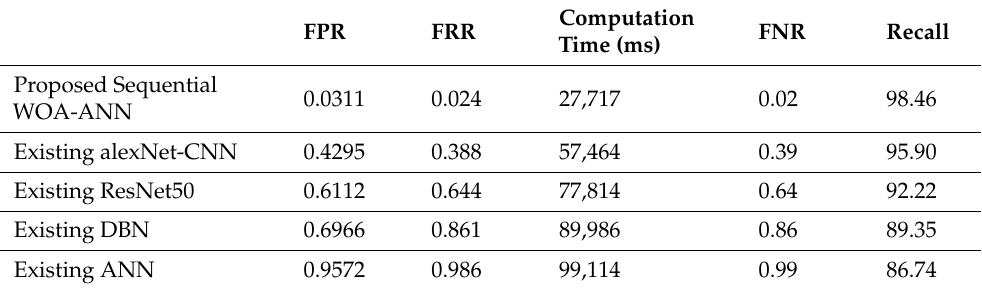
Table 4. Evaluation of classification metrics for proposed sequential WOA-ANN on FPR, FRR and others.